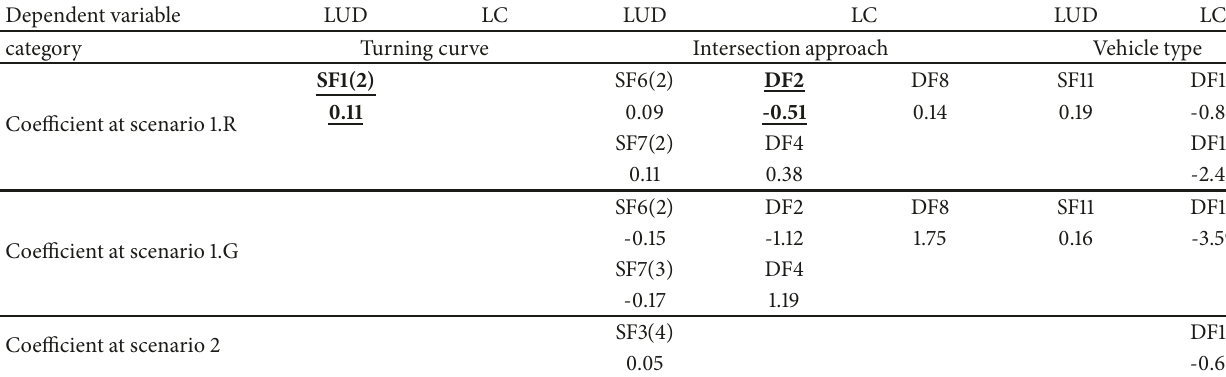
Table 7: Factor coefficients at the DLTLs